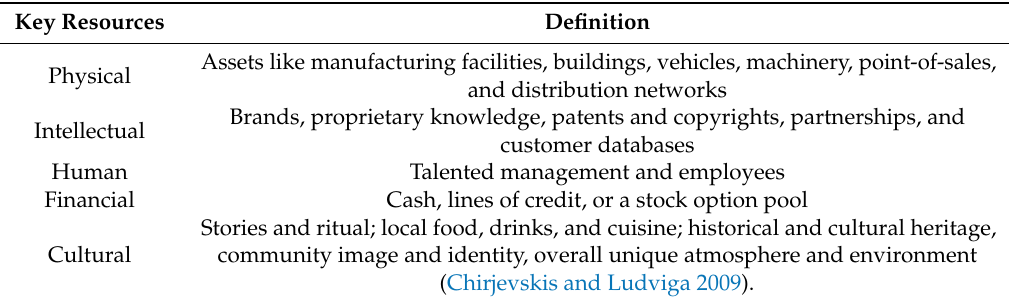
Table 1. Key resources (tangible and intangible).